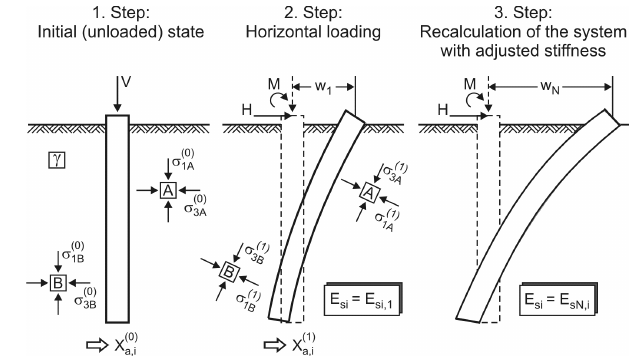
Figure 3. Calculation steps of the stiffness degradation method.